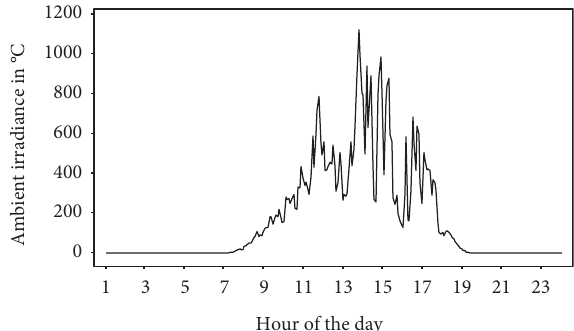
Figure 16: A plot of ambient irradiance at the remote seismic node.